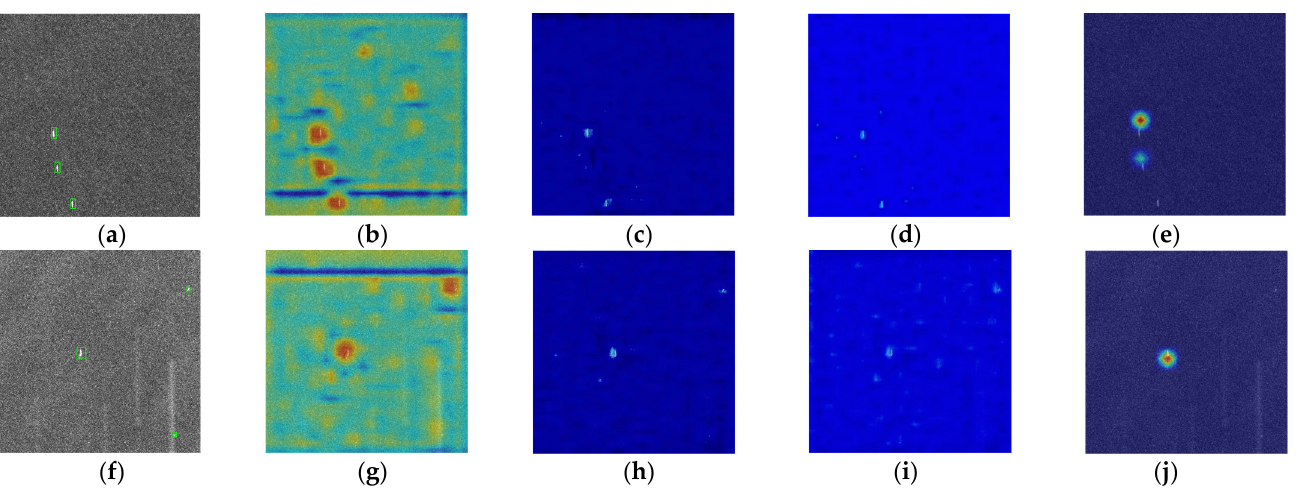
Figure 9. Some visualization results. ( a , f ) represent the original image; ( b , g ) represent the heatmaps of the basic algorithm; ( c , h ) represent the heatmaps of the CLAM module; ( d , i ) represent the heatmaps of the HLEM module. ( e , j ) represent the heatmaps of the refined branch.